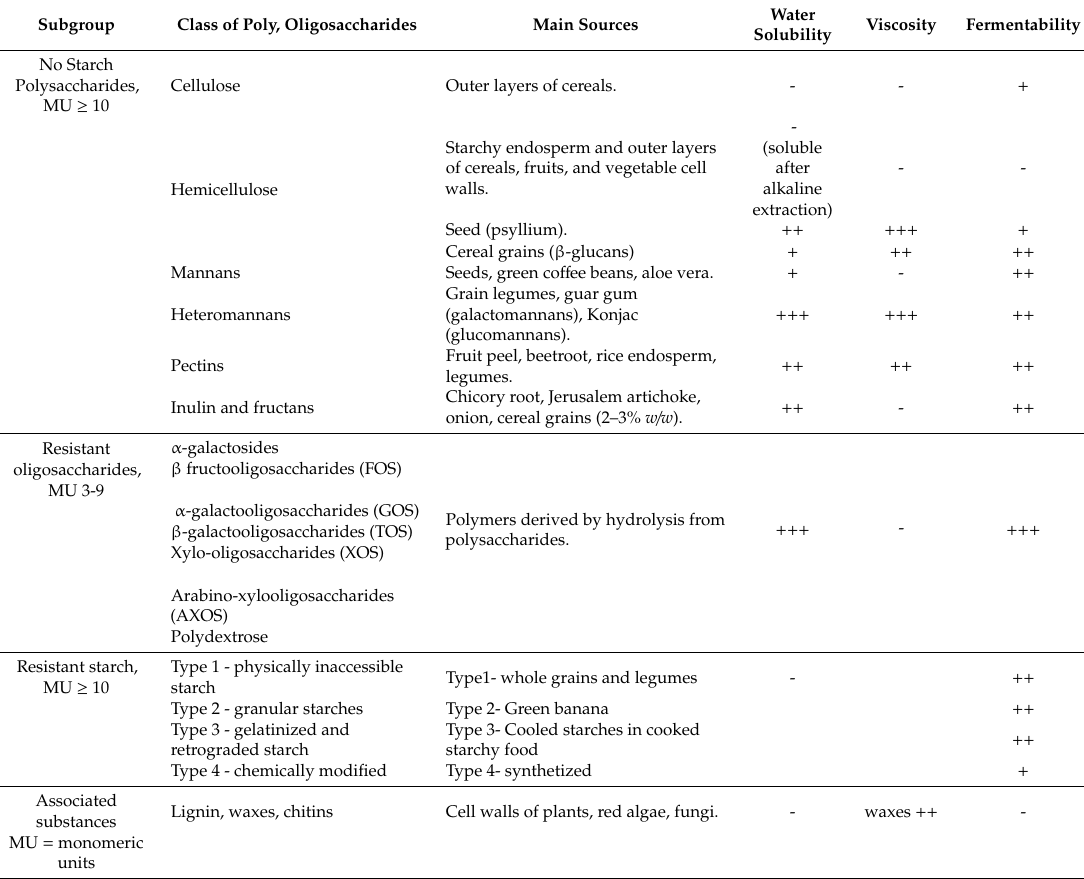
Table 2. Classification of dietary fiber according to main chemical components, main food sources, and intrinsic characteristics (data derived from Stephen et al.